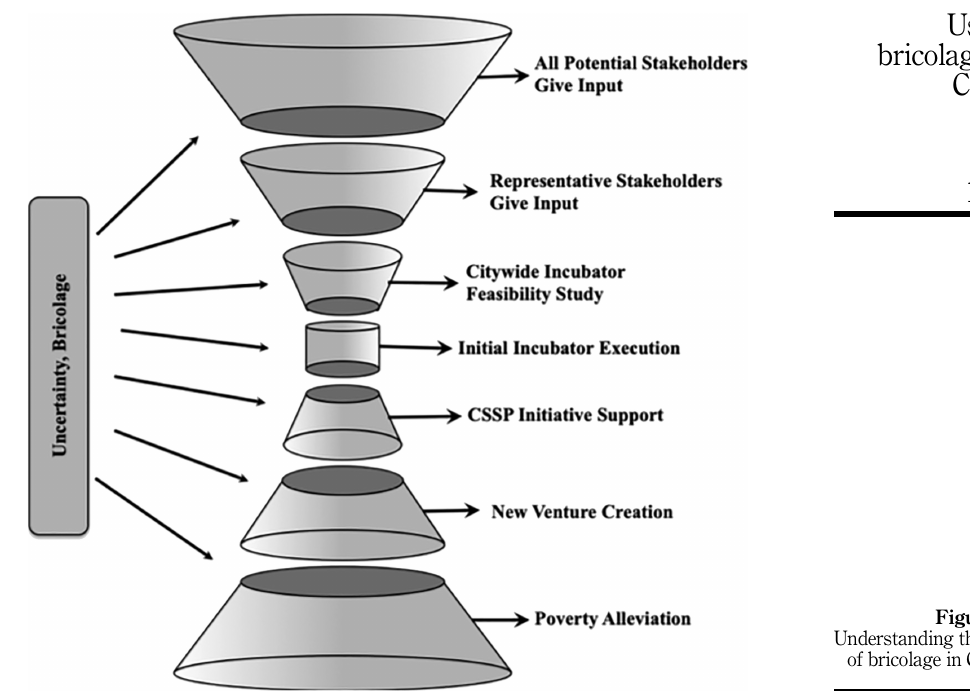
Figure 2. Understanding the role of bricolage in